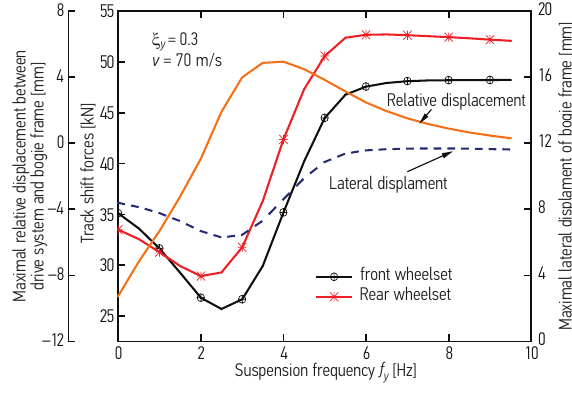
Fig. 6. The simulate results with different f y